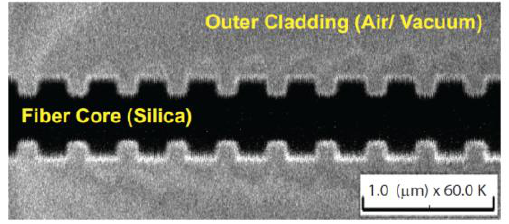
Figure 16. Scanning ion microscope (SIM) image of a nanofiber Bragg grating fabricated using the FIB milling technique. The fiber diameter is ~560 nm. The grating period is ~360 nm, with each groove having a depth of ~100 nm and width of ~150 nm. The scale bar represents 1.0 μm. The image was taken at 60,000  magnification used in the SIM, but the scale bar gives the correct scaling for this image. Reprinted with permission from [104].